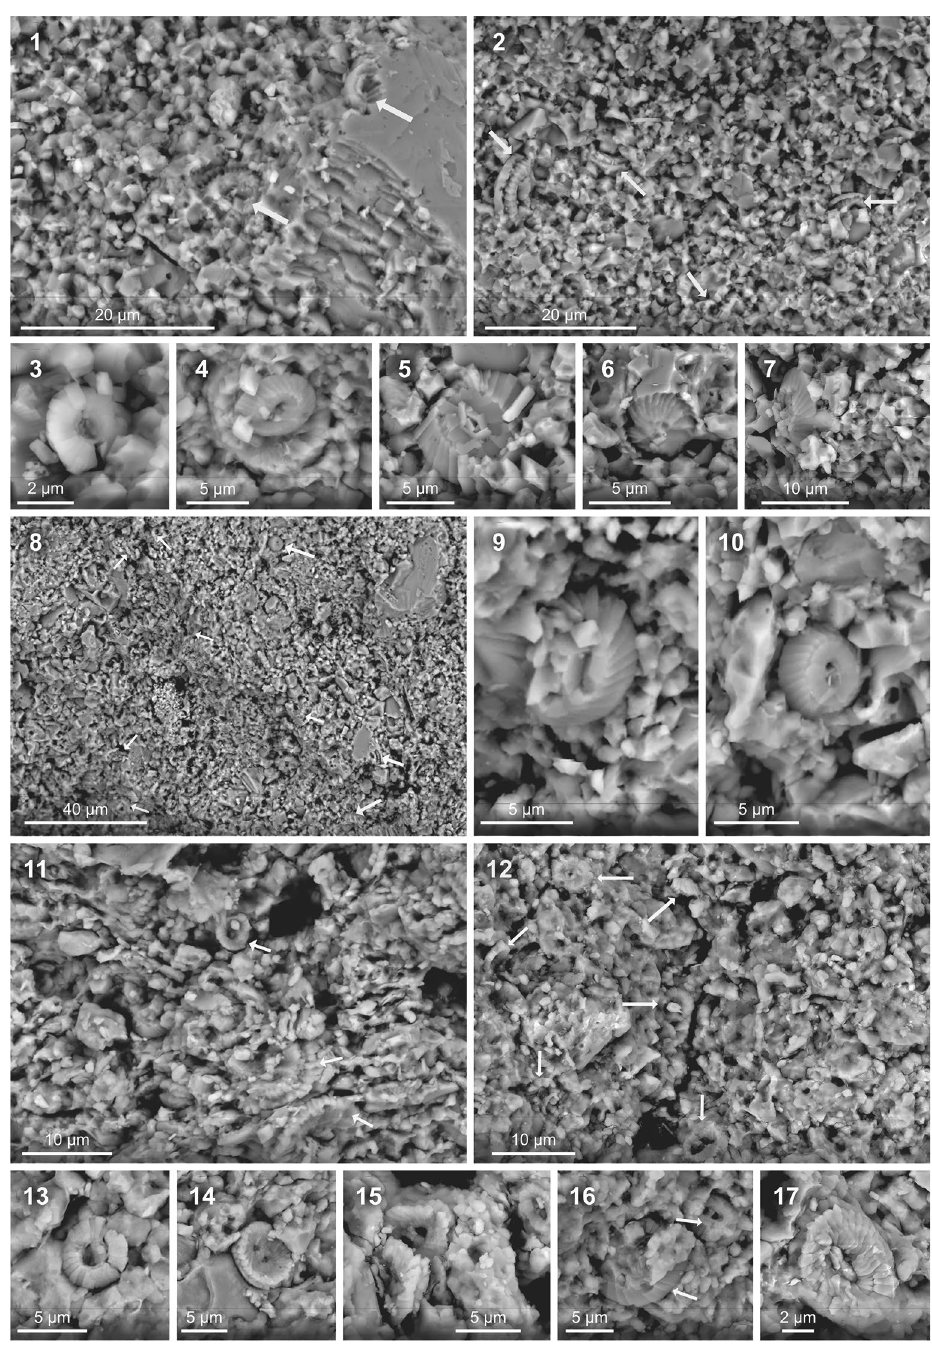
Figure 6. Scanning Electron Microscope (SEM) micrographs of nannofacies. See Fig. 5 for the stratigraphic position of each sample. Scale bar is reported on each micrograph. 1 and 2: Freshly broken limestone surface (samples KS62 and KS69 respectively). Calcareous nannofossils as fabric component are well visible (arrows show only a part of these components) as moulds (1) and fragments (2). 3: Biscutum sp (sample KS62). 4: Placoliths of Watznaueria (sample KS84). 5: Coccolith of Watznaueria distal view (sample KS62). 6: Coccolith of Watznaueria as mould (sample KS92). 7: Coccolith of Watznaueri side view (sample KS69). 8: Freshly broken surfaces of marly limestone (sample KS65). 9 and 10: Close-up of coccoliths indicated by arrows in (8). 11 and 12: Freshly broken surface of marls (samples KS73 and KS80 respectively). Calcareous nannofossils as fabric component are present as entire and fragmented coccoliths (arrows). 13: Discorhabdus sp (sample KS80). 14: Proximal view of coccolith Watznaueria britannica (sample KS80). 15 and 17: Coccoliths of Watznaueria (sample